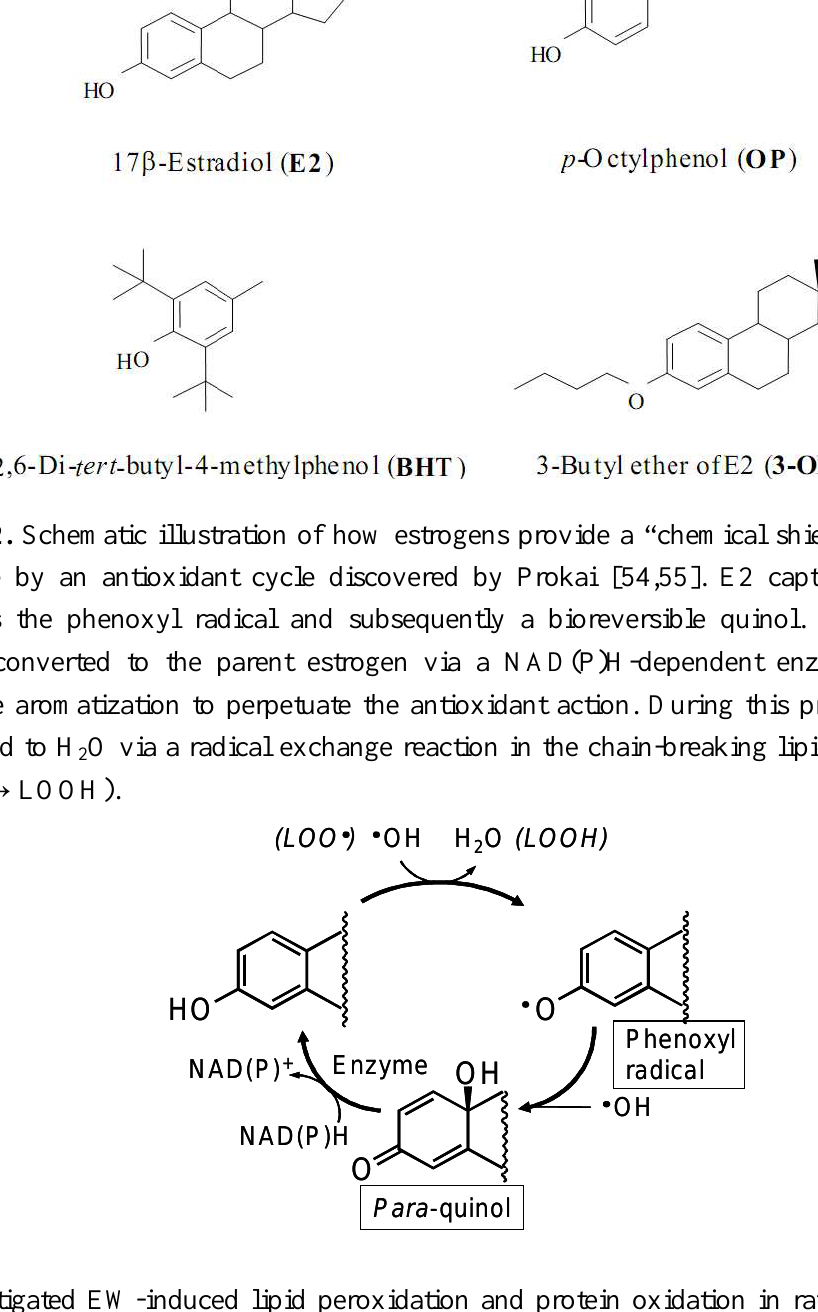
Figure 1. Chemical structures of E2, OP, BHT and 3-OBu-E2.